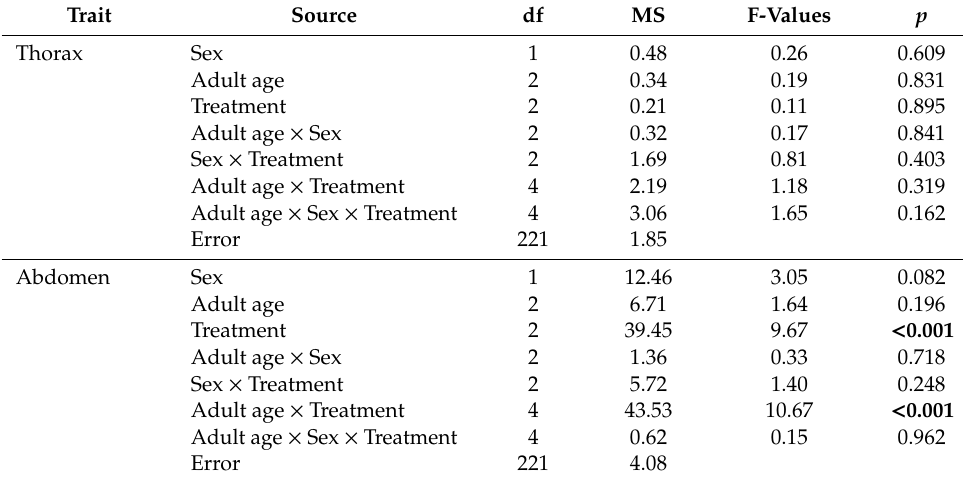
Table 3. Three-way ANOVA for the e ff ects of duration and timing of starvation on triglyceride content in the thorax and abdomen of Cnaphalocrocis medinalis.